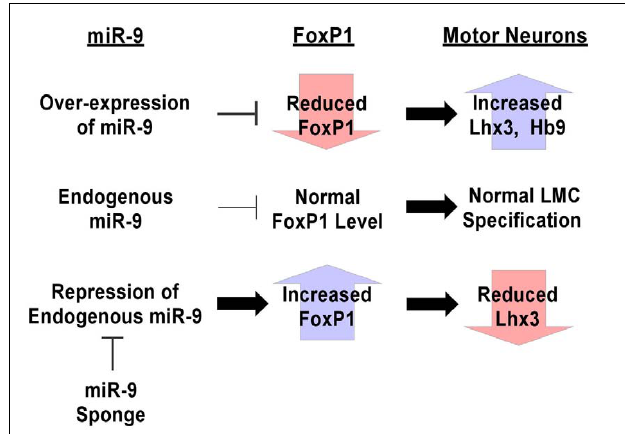
FIGURE 6 | Summary of techniques for manipulation of miRNA expression levels in vivo . Over-expression of miR-9 silences endogenous FoxP1, causing increases in numbers of Lhx3 + and HB9 + MNs, demonstrating the ability of miR-9 to target those pathways. Conversely, miR-9 sponges are able to block miR-9 silencing of endogenous FoxP1, causing increased FoxP1 expression levels and a reduction in Lhx3 + MNs. These design principles can be used for generating tools to investigate the roles of miRNA in systems to which they can be